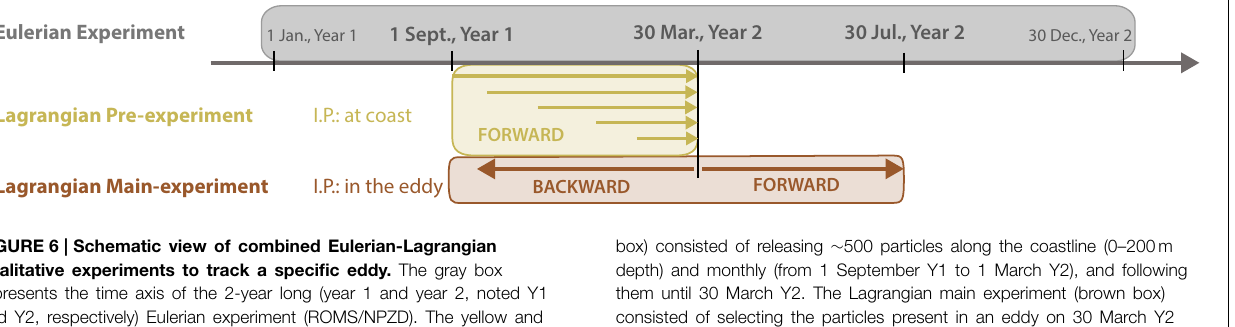
FIGURE 6 | Schematic view of combined Eulerian-Lagrangian qualitative experiments to track a specific eddy. The gray box represents the time axis of the 2-year long (year 1 and year 2, noted Y1 and Y2, respectively) Eulerian experiment (ROMS/NPZD). The yellow and brown boxes represent two complementary Lagrangian experiments based on the Eulerian outputs. The Lagrangian pre-experiment (yellow